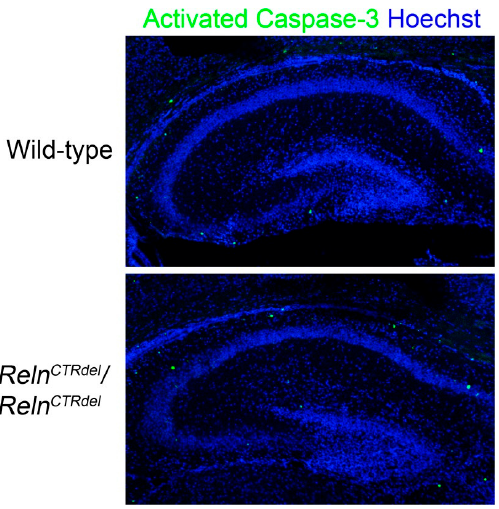
Figure A1. Cell death analysis. Activated caspase-3 (green) staining at P4 showed no abnormal increase in cell death in Reln CTRdel hippocampus. Nuclei were stained using Hoechst (blue).